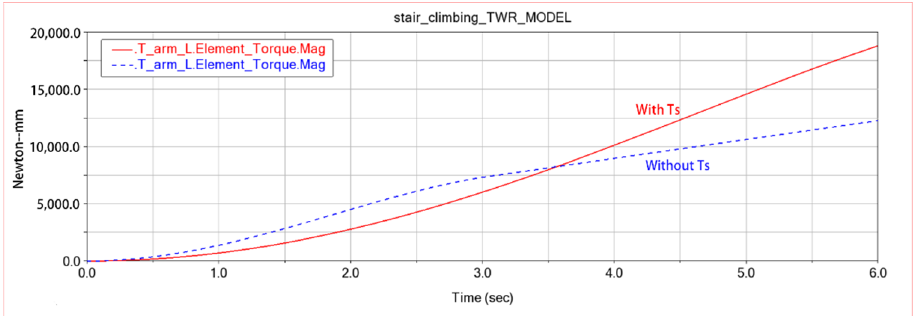
Figure 11. Output torque of the cantilever angle ring before and after adding T S .